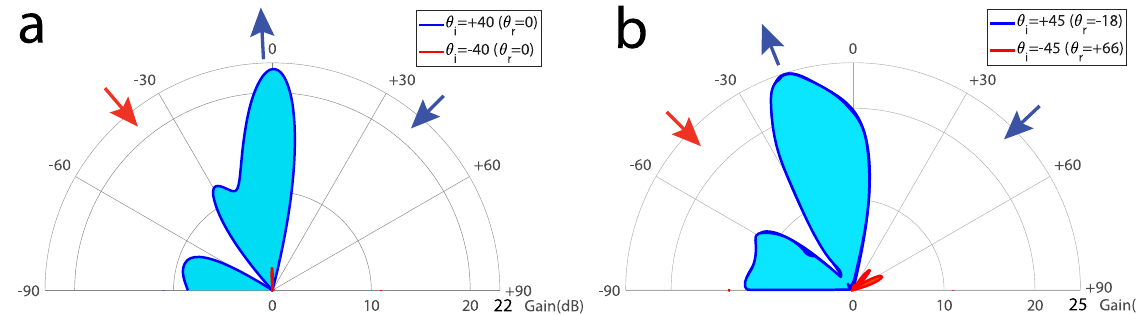
Fig. 8 Experimental results for nonreciprocal wave ampli fi cation at 5.81 GHz. a θ i = 40°. b θ i = 45°.